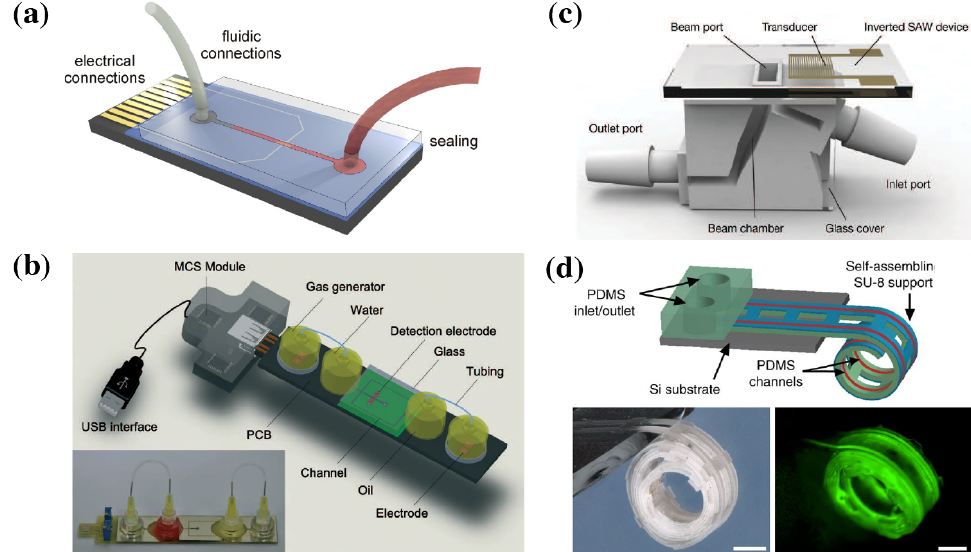
Figure 10. ( a ) Schematic of a microfluidic chip with sealed fluidic channels and microfluidic and electrical connections [66]. ( b ) Complex integrated microfluidic device, including reservoirs, pumps, and USB interface electronics [67]. ( c ) 3D-printed fluidic accessory [70]. ( d ) Self-assembling microfluidic